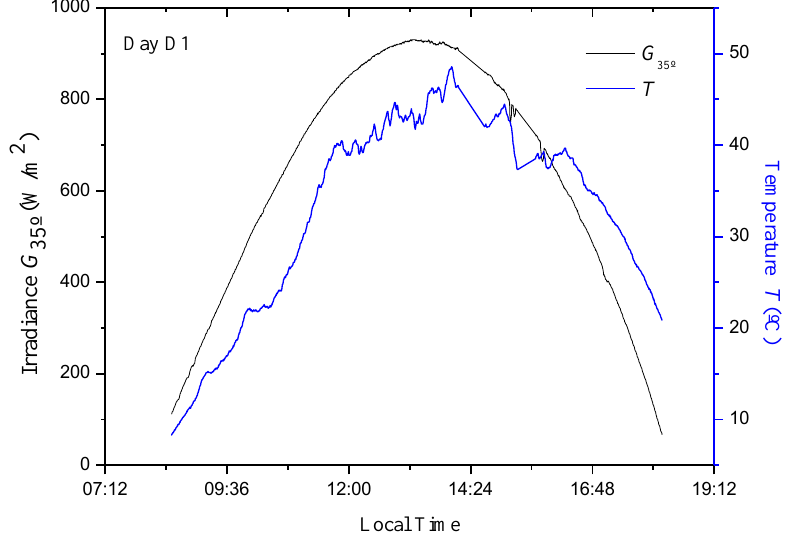
Figure 1. T and G 35° values in the photovoltaic generator (PVG) for D1 day.